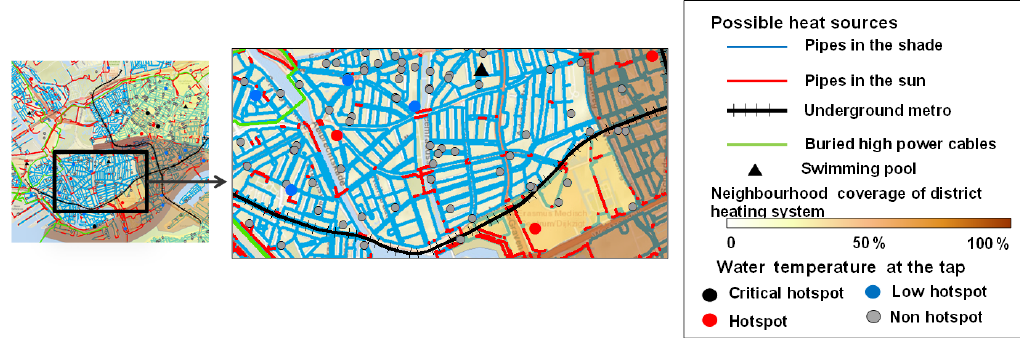
Figure 7. Detail of the GIS analysis for a small area of the case study.